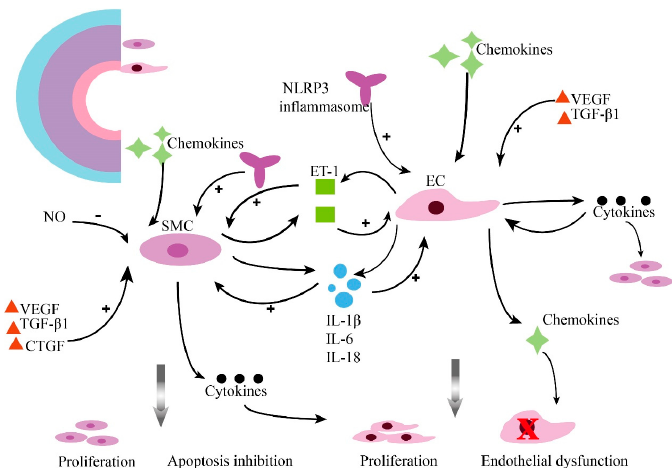
Figure 2. Inflammation contributes to pulmonary vascular remodeling in PAH. Pulmonary vascular lesions subsist in a tremendously inflammatory microenvironment. Pulmonary arterial smooth muscle cells (PASMCs) and pulmonary arterial endothelial cells (PAECs) crosstalk, resulting in changed sensitivity to inflammatory factors and their promoted potential to promote the inflammatory response. (ET-1, endothelin 1; SMC, smooth muscle cells; EC, endothelial cells; NO, nitric oxide; VEGF, vascular endothelial growth factor; TGF- β 1, transforming growth factor- β 1; IL-1 β , interleukin 1-beta; IL-6, interleukin 6; IL-18, interleukin-18; CTGF, connective tissue growth factor; NLRP3, Nod-like receptor protein 3).